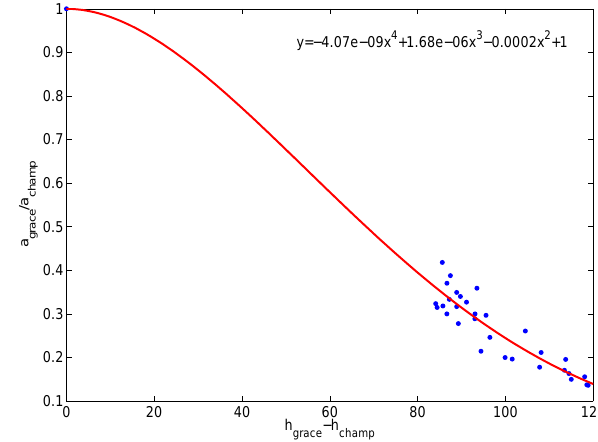
Fig. 8. The dependence of the ratio of the scale factor a from CHAMP and GRACE on the height difference between the two